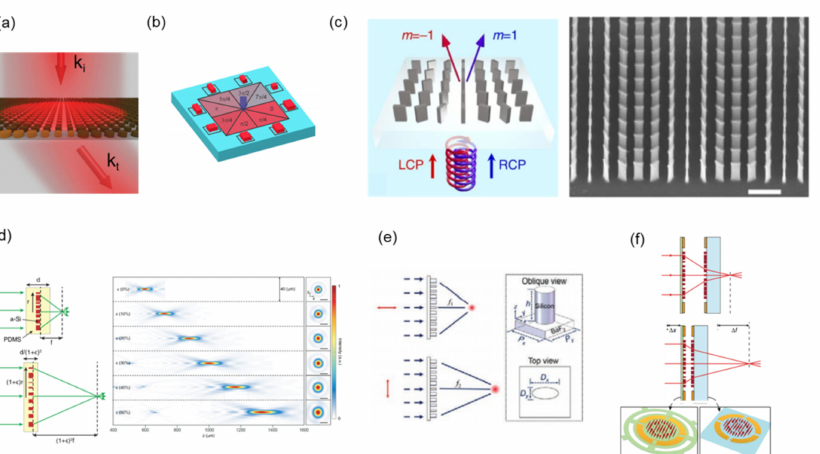
Figure 3. ( a ) Beam deflection metasurface [122]. ( b ) Phase distribution of an optical vortex metasur- face [125]. ( c ) Schematic (left) of a-Si grating that redirects impinging light based on its handedness; SEM image (right) of a-Si grating with a scale bar of 1 µ m [126]. ( d ) Schematic of a dielectric met- alens with a tunable focal distance (left); measured optical intensity profiles of a tunable metalens (right) [136]. ( e ) Polarization-controlled focusing metalens [137]. ( f ) Tunable lens that consists of a stationary lens on a substrate and a moving lens on a membrane